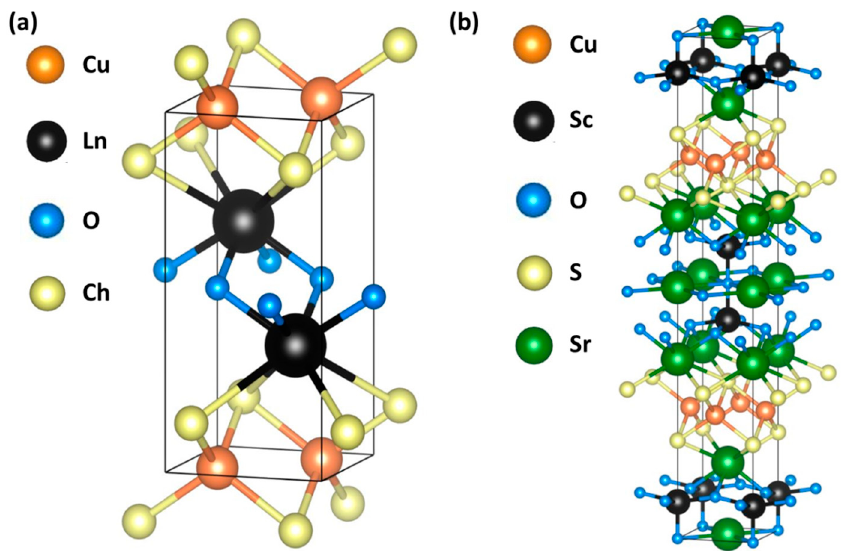
Figure 7. Crystal structure of ( a ) LnCuOCh (Ln = La, Y, Pr, etc., and Ch = S, Se, Te, etc.) and ( b ) [Cu 2 S 2 ][Sr 3 Sc 2 O 5 ].